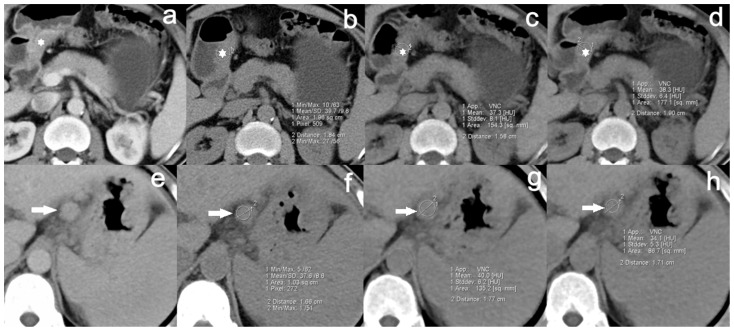
VNE images were acceptable for diagnosis purpose.
a∼d A 56-year-old man with advanced gastric cancer in the lesser curvature of the antrum. a Transverse CT scans show focal wall thickening (asterisk) of the lesser curvature of the gastric antrum with abnormal enhancement. VNEA image (c), VNEP image (d) and TNE image (b) show good correlation of measured CT numbers and thickness of the tumor (TNE: 39.7 HU±9.6, 1.84 cm; VNEA: 37.3 HU±8.1, 1.58 cm; VNEP: 38.3 HU±6.4, 1.90 cm). e∼h A 62-year-old man with advanced gastric cancer in the fundus. e Transverse CT scans show an enlarged lymph node (arrow) in the lesser curvature of the gastric body. VNEA image (g), VNEP image (h) and TNE image (f) show good correlation of measured CT numbers and diameter of the node (TNE: 37.6 HU±8.6, 1.66 cm; VNEA: 40.0 HU±6.2, 1.77 cm; VNEP: 34.1 HU±5.3, 1.71 cm). Both of the patients are noted excellent VNE image quality.